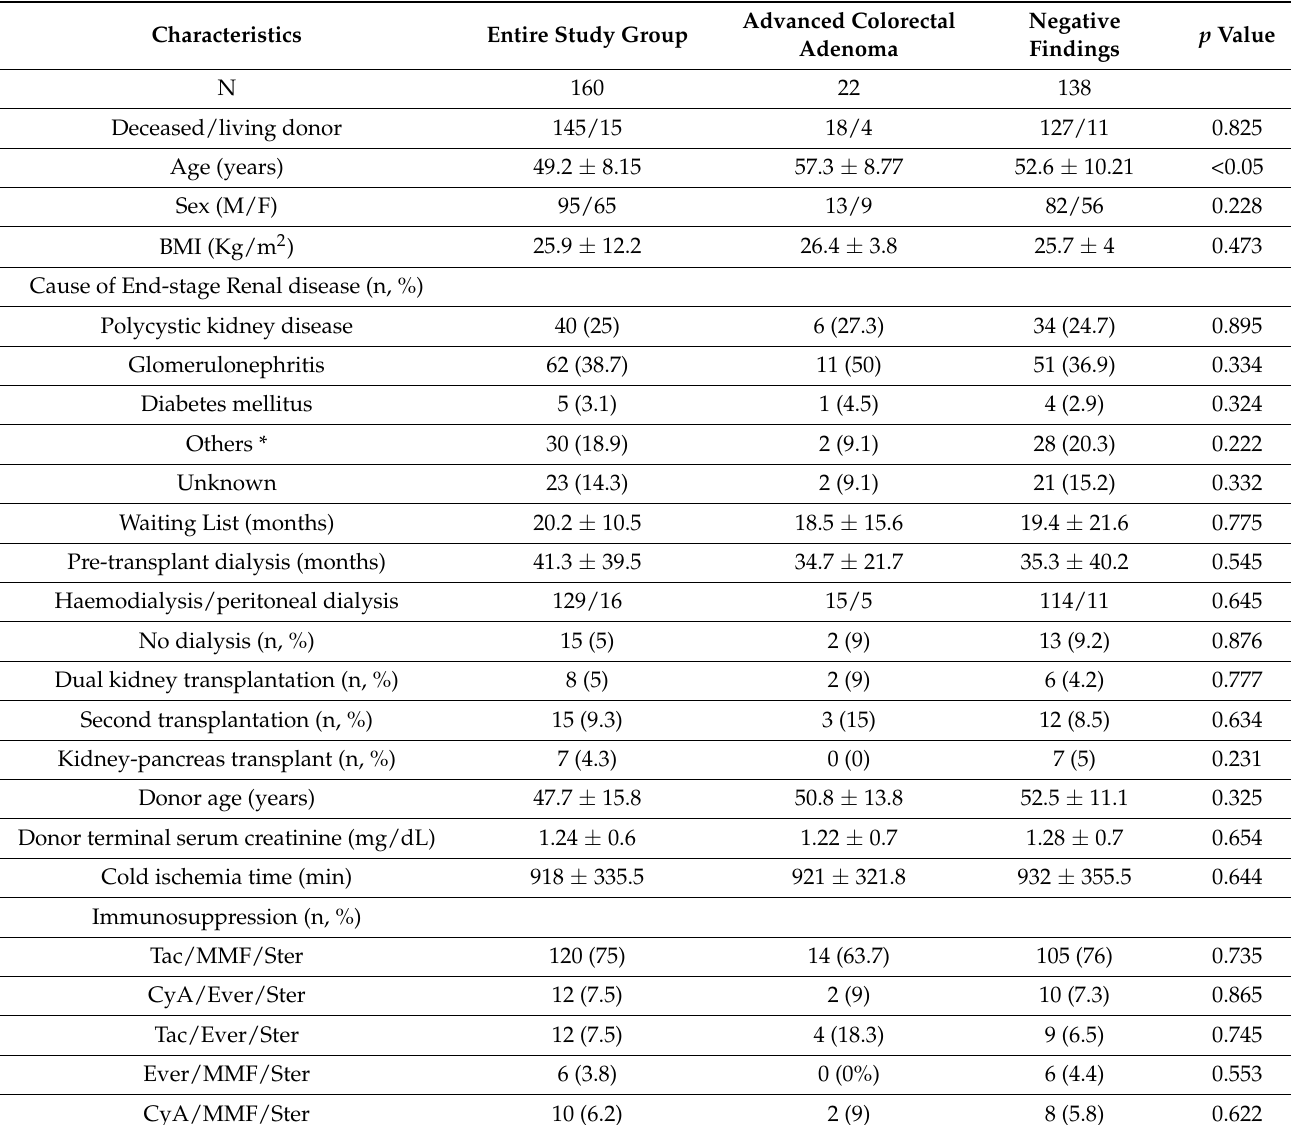
Table 1. The clinical data of 160 kidney transplant recipients undergoing post-transplant colonoscopy. Patients with advanced colorectal neoplasia (22 patients) were compared with those without colorectal neoplasia (138 patients). Characteristics Entire Study Group